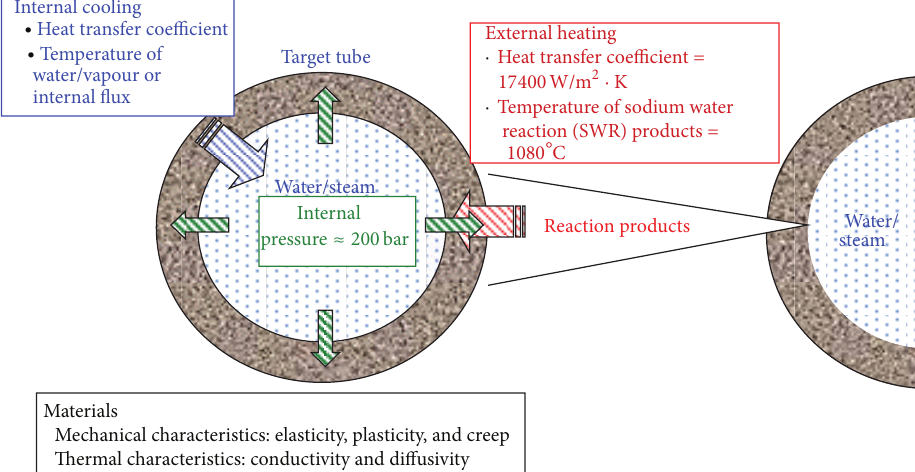
Figure 1: Boundary conditions, initial conditions and model data.